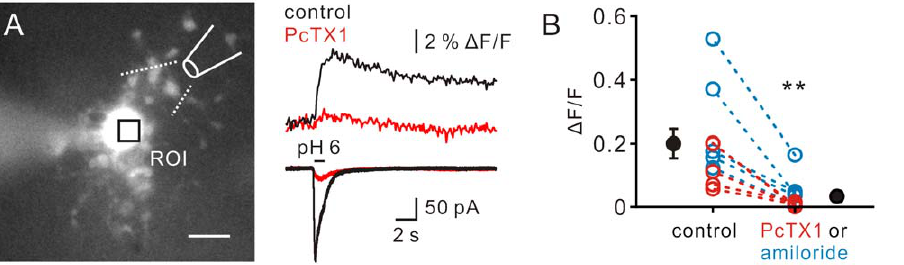
Figure 5. Activation of ASIC1a channels results in [Ca 2 + ] i elevation. (A) Fluorescence image of an NG2 cell loaded with OGB-1. Square, the region of interest (ROI). Scale bar, 10 m m. Traces, an example of focal acid puffing to an NG2 cell induced changes of fluorescence signals (top) at the ROI in the control (black) and in the presence of PcTX1 (red) and their corresponding inward currents (bottom). (B) Summary of the change of peak amplitude of [Ca 2 + ] i in the control and in the presence of PcTX1 or amiloride. ** P ,